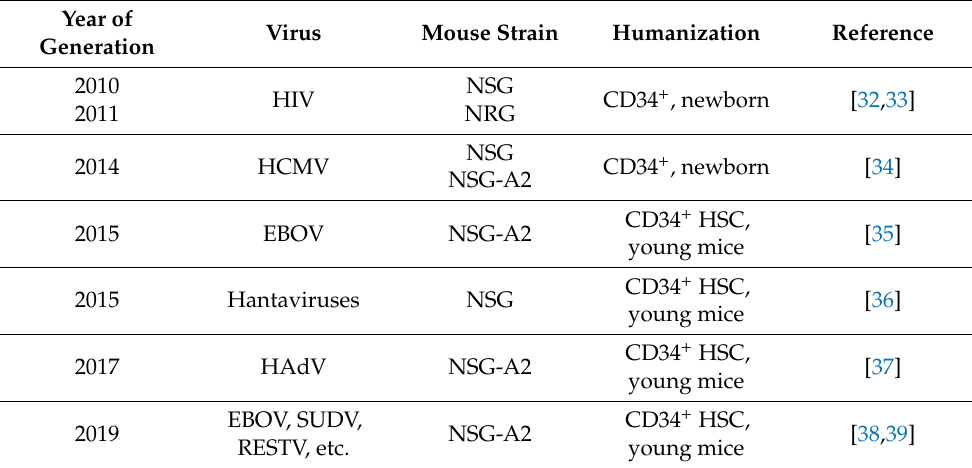
Table 1. Summary of the humanized mouse models and applications reviewed in this paper.